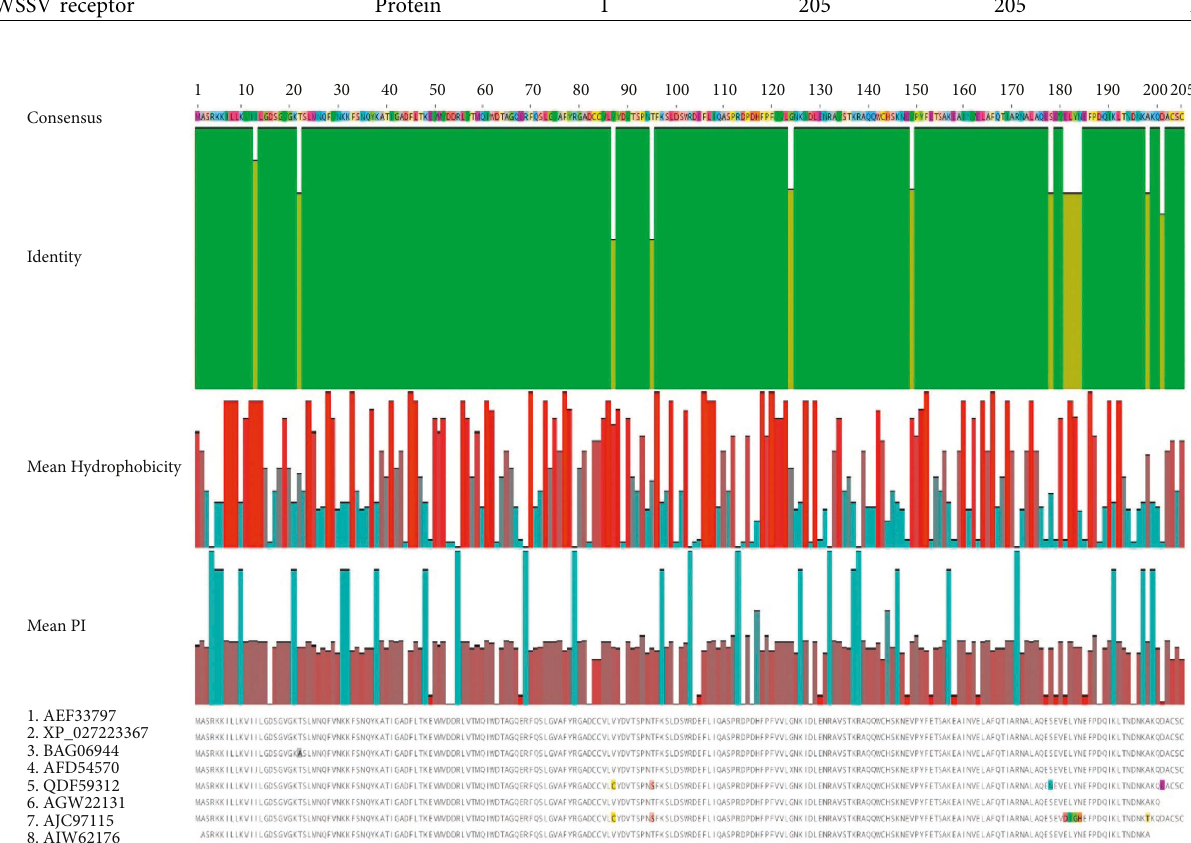
Figure 1: Mean hydrophobicity, isoelectric point, and identity of eight Rab7 sequences from decapod isolates after multiple sequence alignment including disagreements to